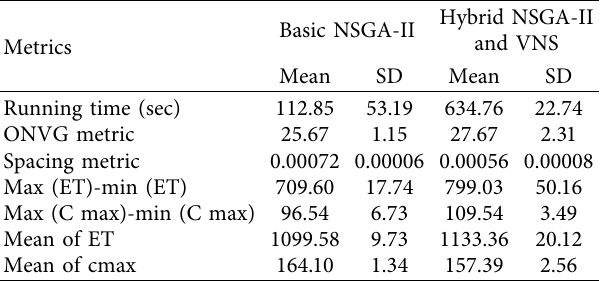
Table 3: Comparison of the quality of simple and hybrid mode